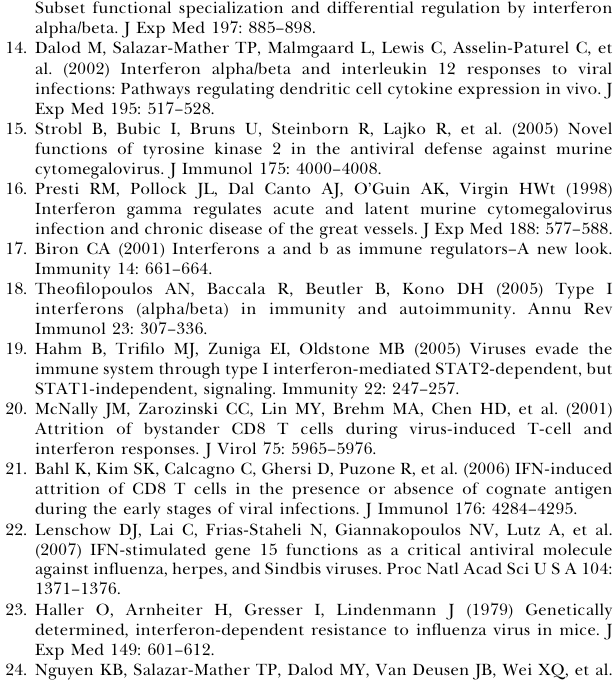
Figure S2. Impact of High Dose and Low Dose MCMV Infections, and of NK Cell Depletion, on Systemic IFN- a / b Production in Klra8 Mice Found at doi:10.1371/journal.ppat.0030123.sg002 (864 KB TIF). Figure S3. Accelerated Acquisition of CD8 T Cell Effector Functions in Klra8 Mice in Response to MCMV Infection Found at doi:10.1371/journal.ppat.0030123.sg003 (502 KB TIF). Figure S4. Kinetics of Antigen-Specific CD8 T Cell Expansion in Klra8 and BALB/c Mice in Response to L. monocytogenes Infection Found at doi:10.1371/journal.ppat.0030123.sg004 (385 KB TIF). Figure S5. Assessment of the Efficiency of NK Cell Depletion Found at doi:10.1371/journal.ppat.0030123.sg005 (223 KB